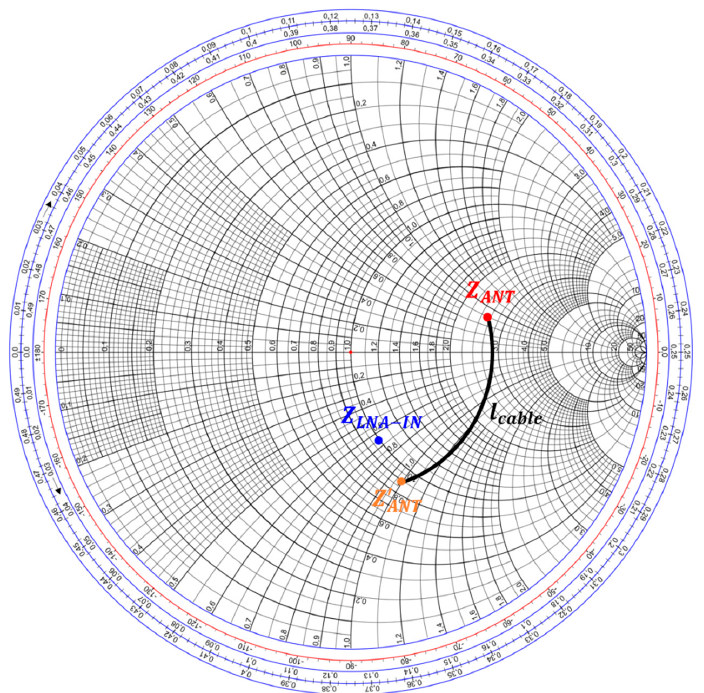
Figure 7. Smith chart of input impedances of the proposed antenna and LNA at 915 MHz.